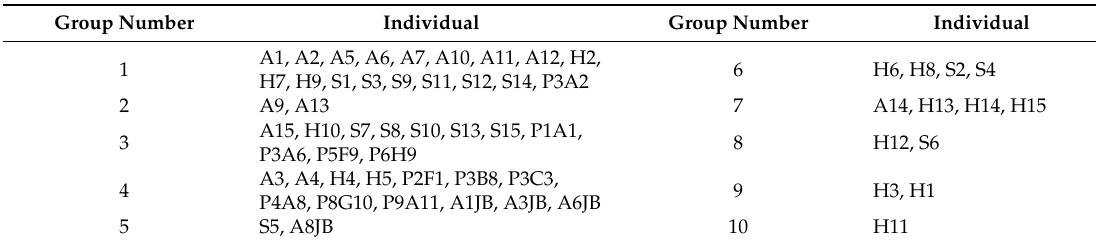
Table 6. Grouping of 60 argan variants with high resolution melting (HRM) analysis of the Delta-6 desaturase ( D6D )